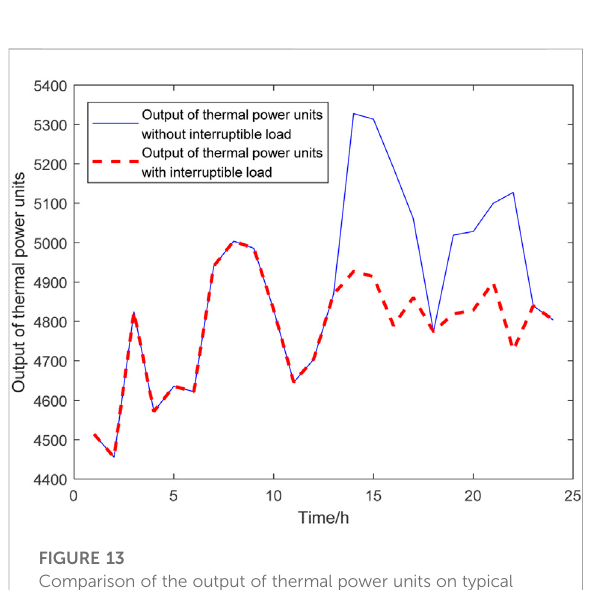
FIGURE 13 Comparison of the output of thermal power units on typical day 2 with 4 million kW interruptible loads.